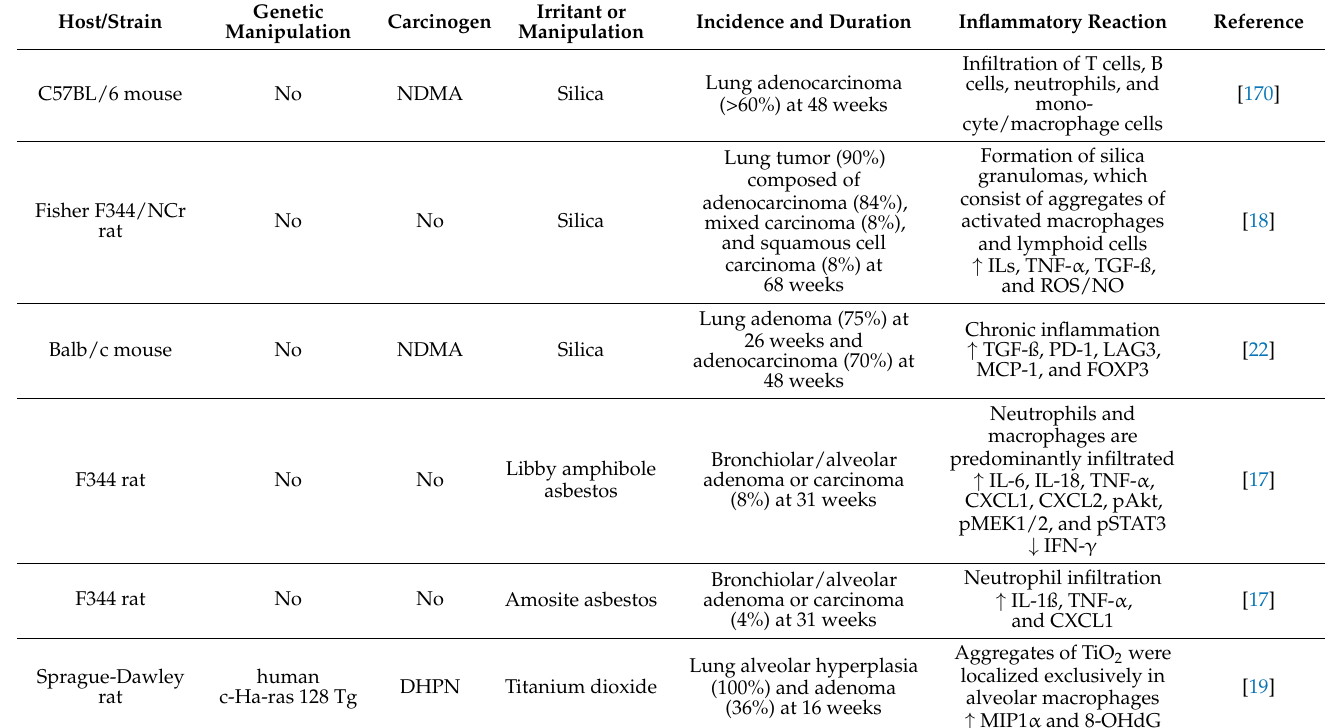
Table 5. Foreign body-induced inflammation-related carcinogenesis